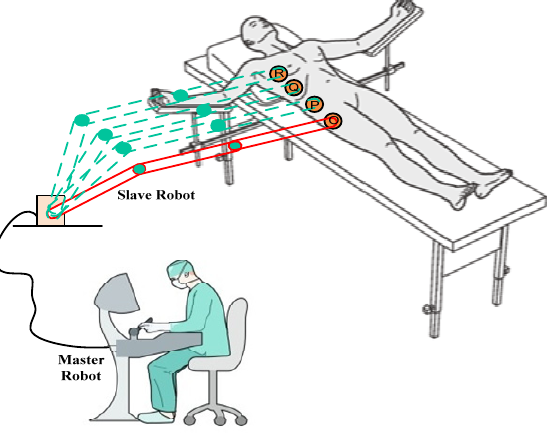
Figure 8. Case study for RAS with nonlinear incision trajectory.